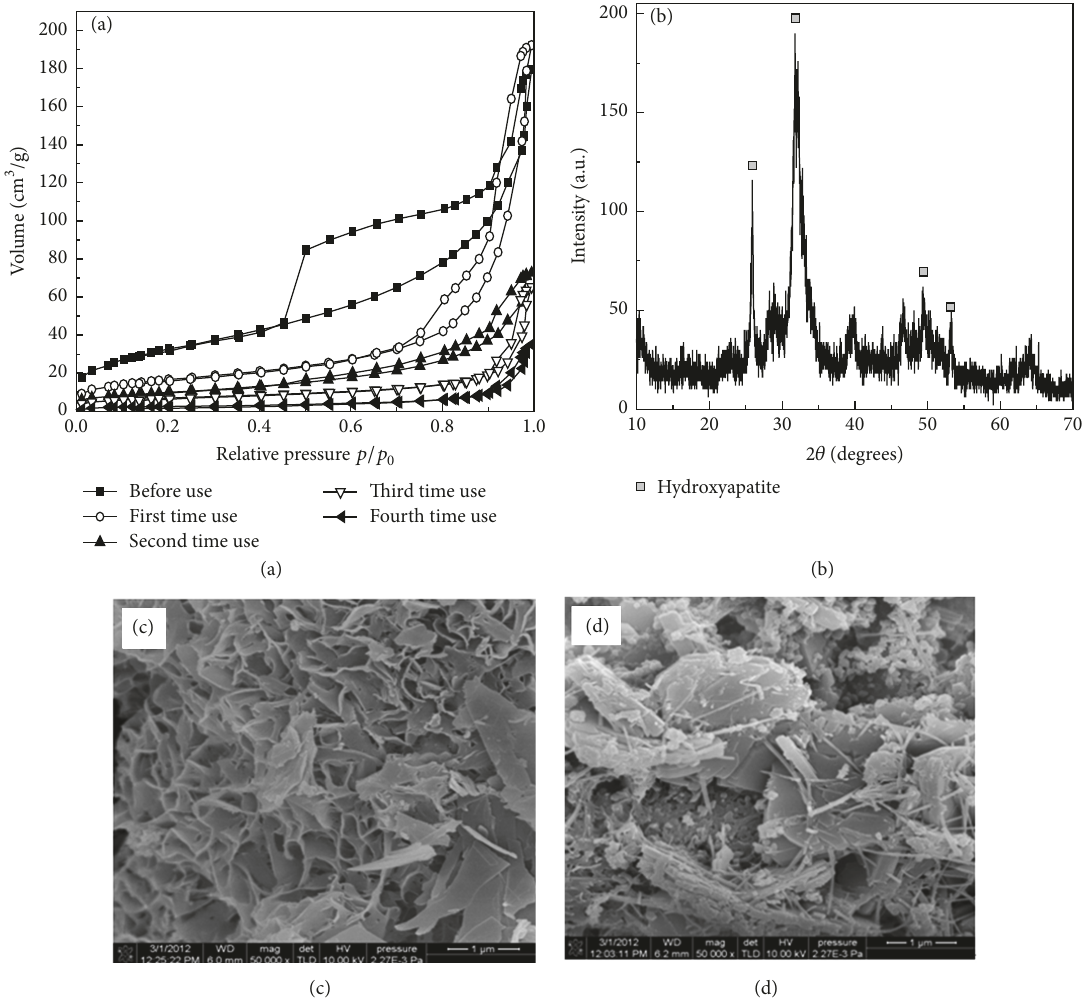
Figure 9: The characterization of deposition: (a) the N 2 adsorption-desorption isotherms for different times of using P-CSHs-PEG2000; (b) XRD patterns of deposit; (c) SEM images of P-CSHs-PEG2000 before use; (d) SEM images of P-CSHs-PEG2000 after four times use.